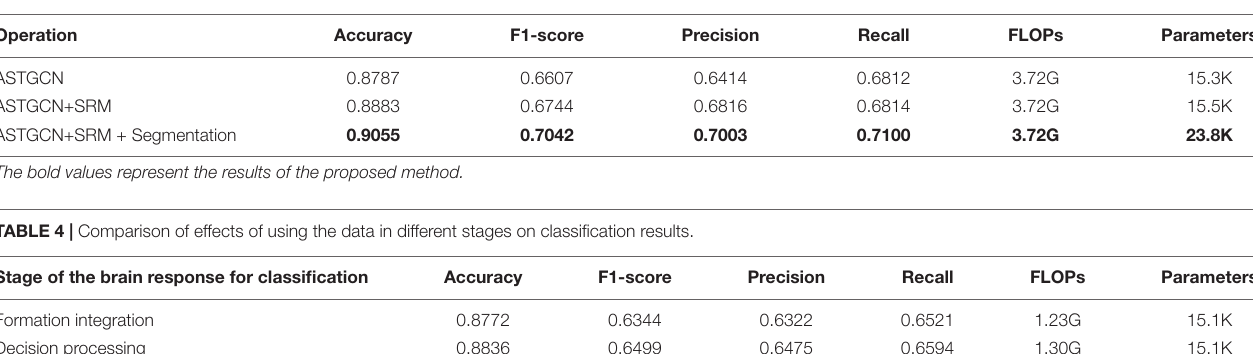
TABLE 3 | Ablation studies.